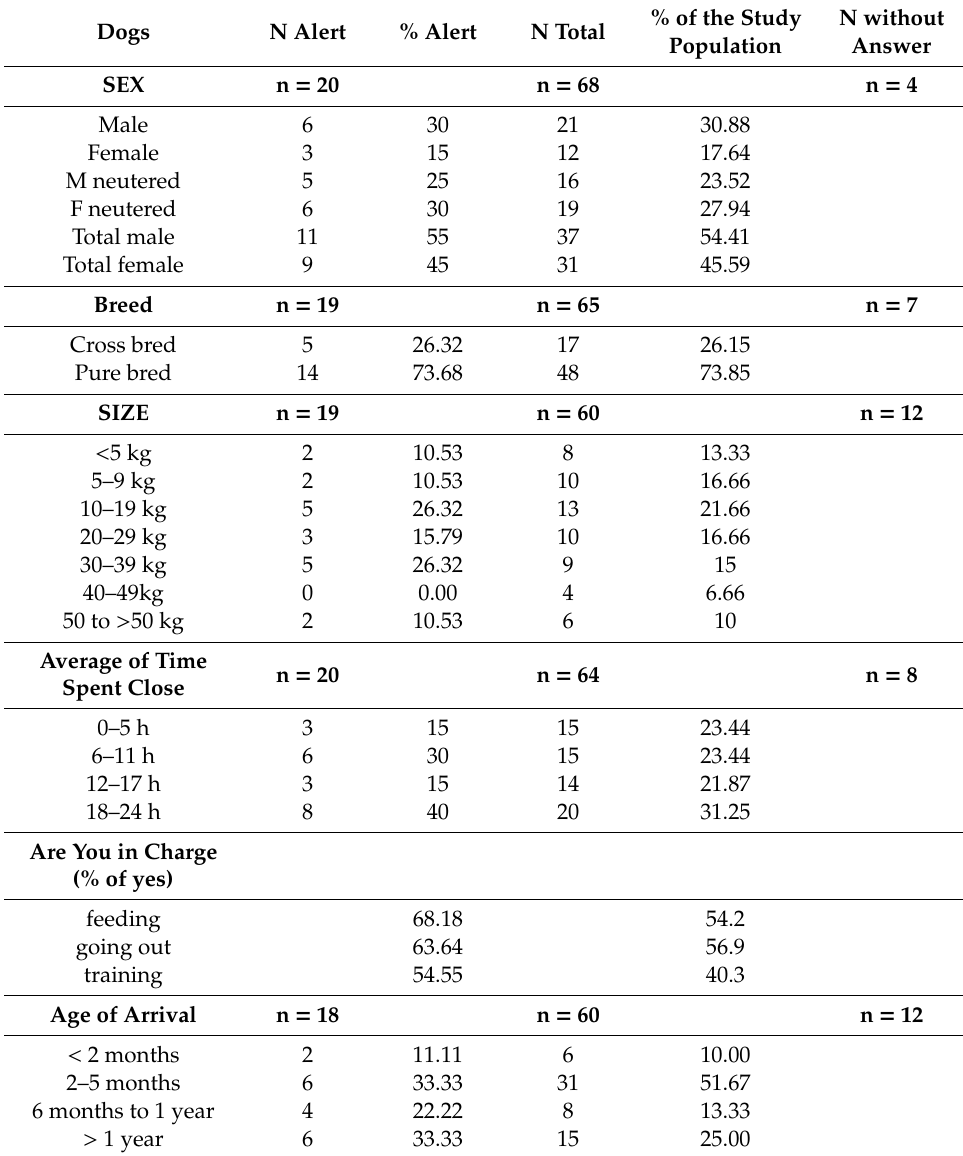
Table 3. Demographics of dogs in our study